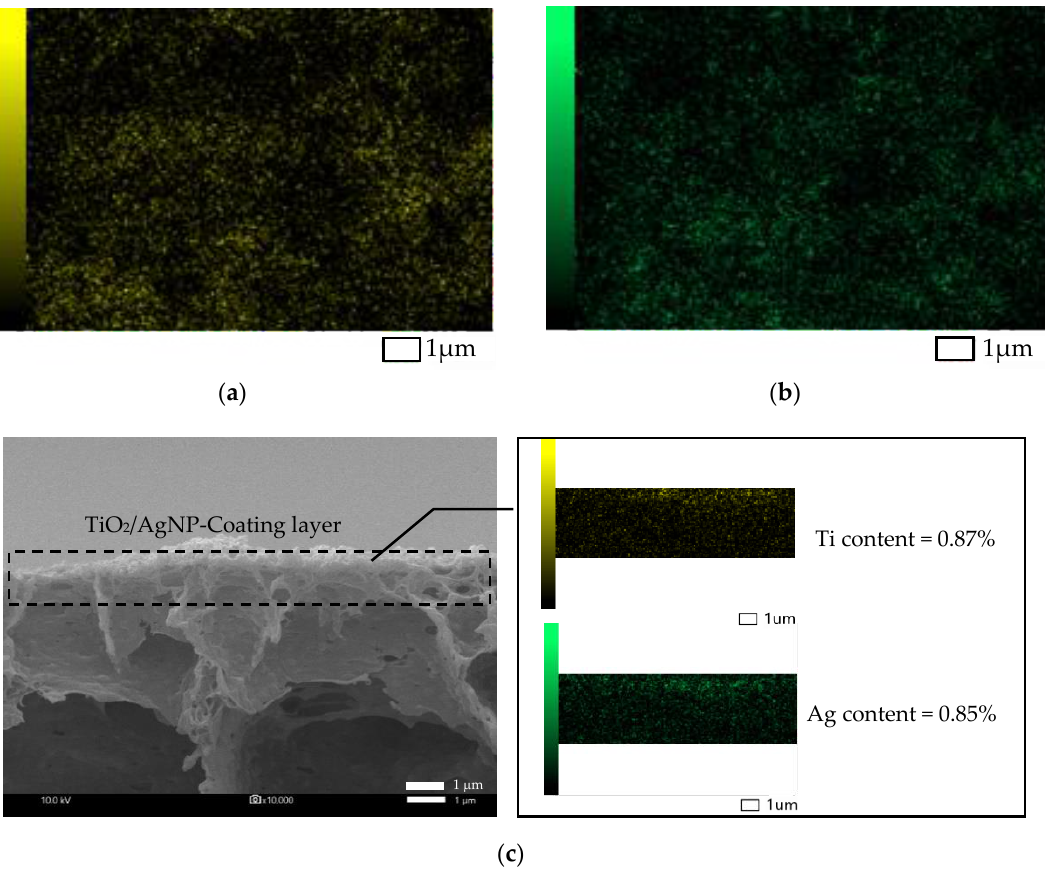
Figure 4. Mapping of particle distribution of modified membrane with 10 ppm TiO 2 and 10 ppm AgNP for 24 h (M4): ( a ) TiO 2 -NP on membrane surface; ( b ) AgNP on membrane surface; and ( c ) TiO 2 -NP and AgNP of X-section (magnification ×10,000).